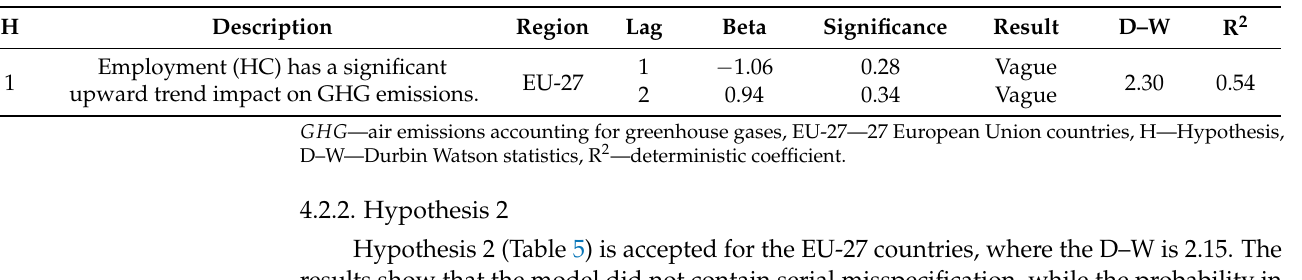
Table 4. Testing Hypothesis